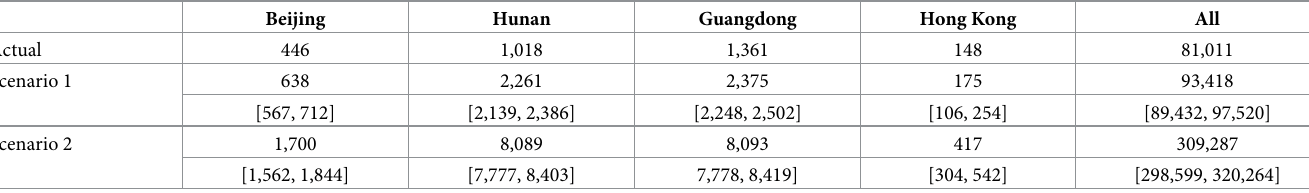
Table 1. Number of infections under counterfactual